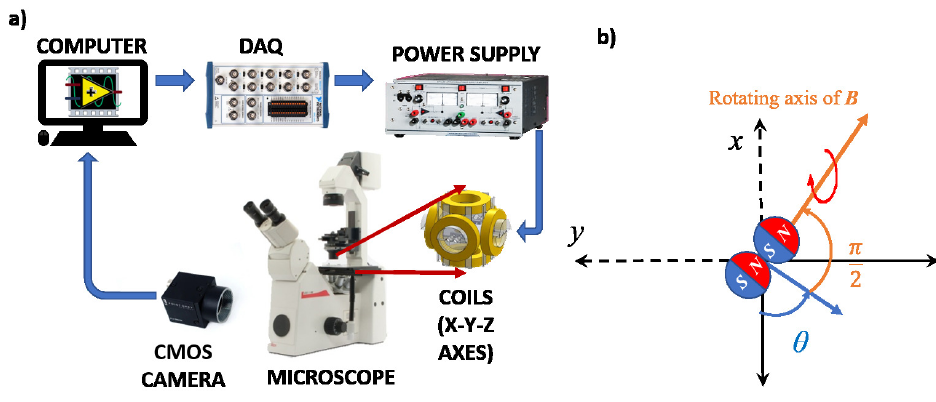
Figure 2. ( a ) The experimental hardware scheme is shown. The videos and the images are captured by a CMOS camera attached to the microscope. ( b ) The rolling motion on Cartesian space is depicted. The symbol θ in blue represents the current heading